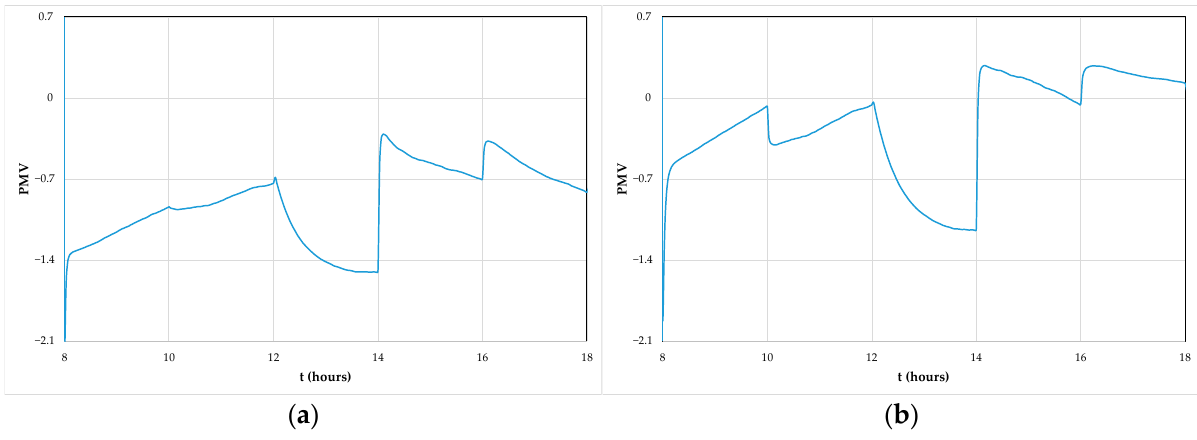
Figure 25. Evaluation of predicted mean vote (PMV) index for the Case C ( a ) and Case D ( b ).